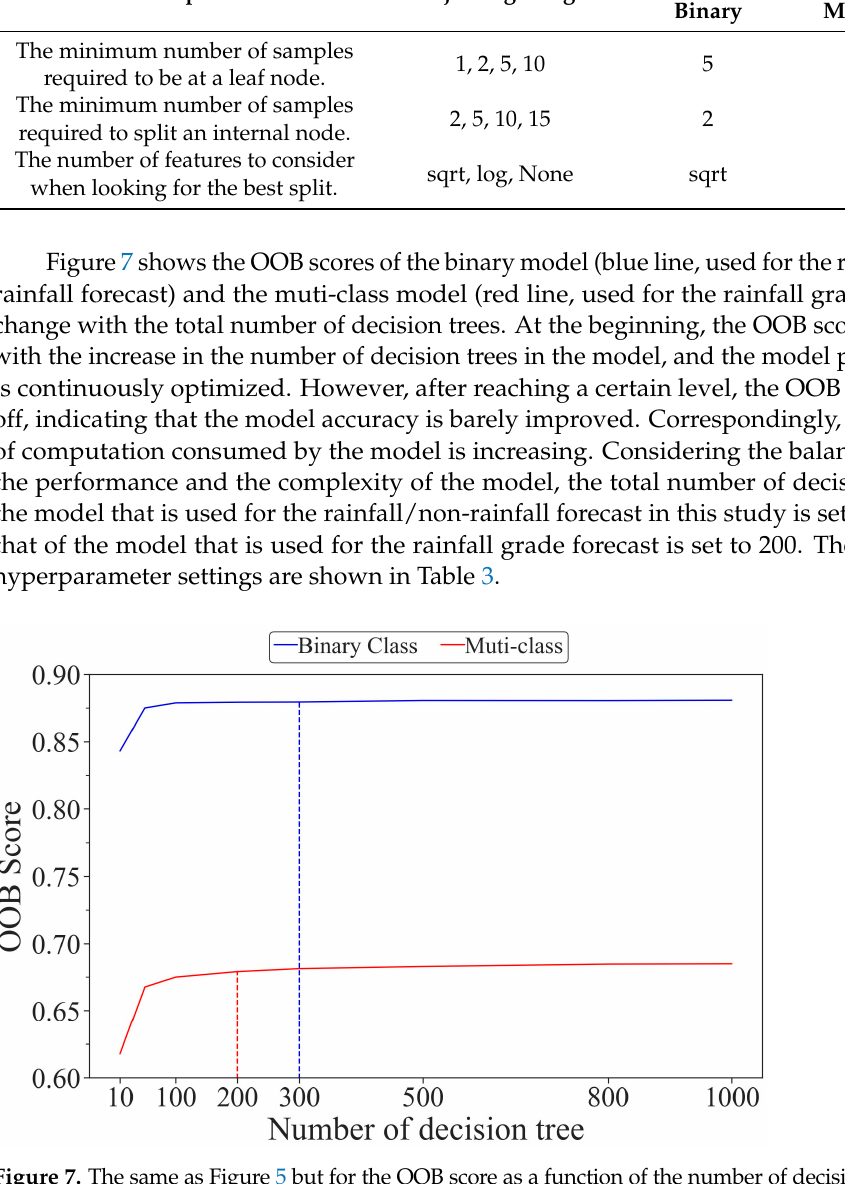
Figure 7. The same as Figure 5 but for the OOB score as a function of the number of decision trees